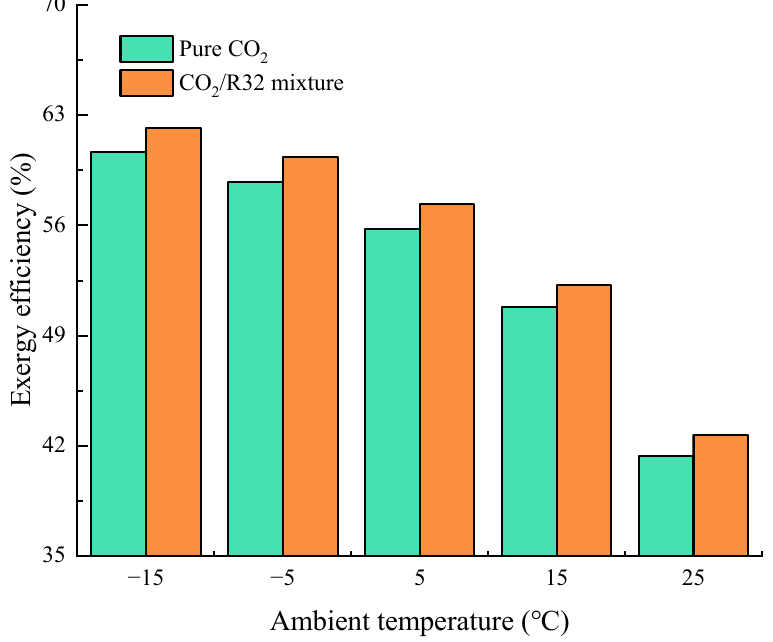
Figure 11. Comparison of the exergy efficiency with pure CO 2 and CO 2 /R32 mixture refrigerants under a range of ambient temperatures.